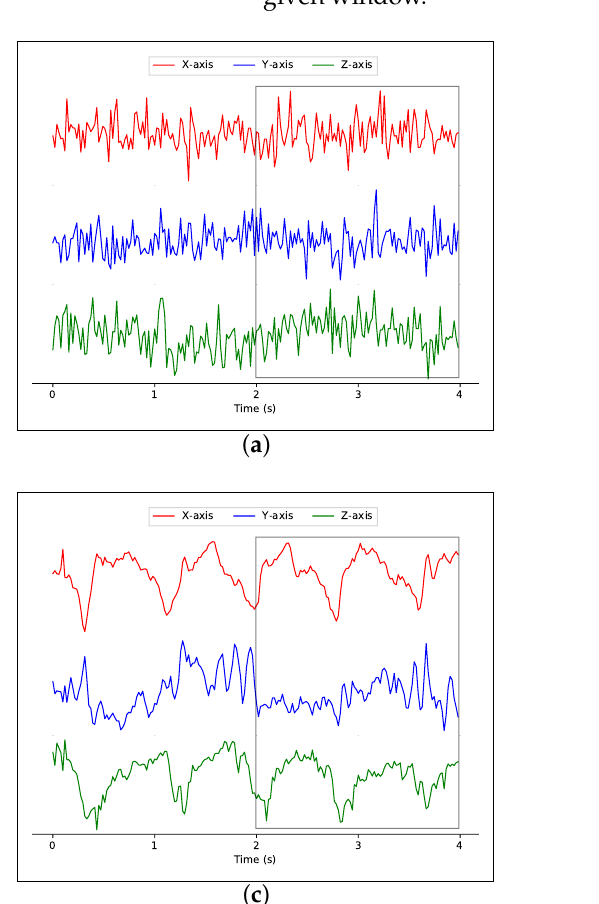
Figure 4. Tri-axial accelerometer data from the IMU placed on the chest for different physical activities (x-axis, top; y-axis, middle; z-axis, bottom): ( a ) standing; ( b ) walking; ( c ) climbing stairs; ( d )